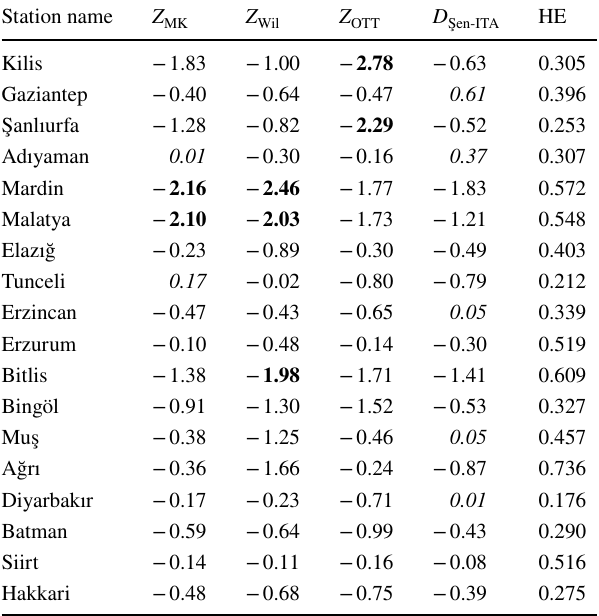
Table 3 Z statistics of different trend analysis methods and H